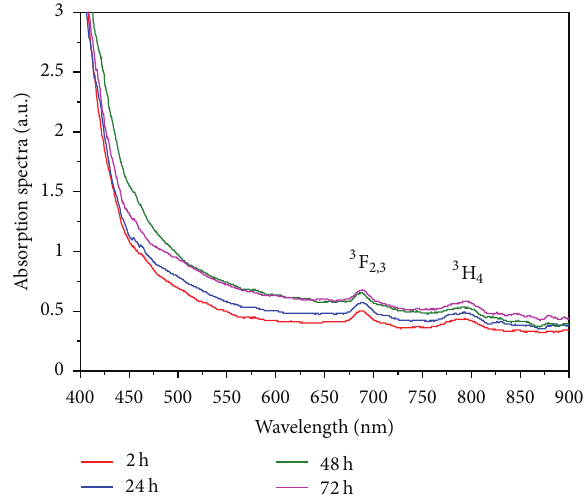
Figure 9: Absorption spectra of TZO-Tm:Ag glasses for different heat-treatment times [3].